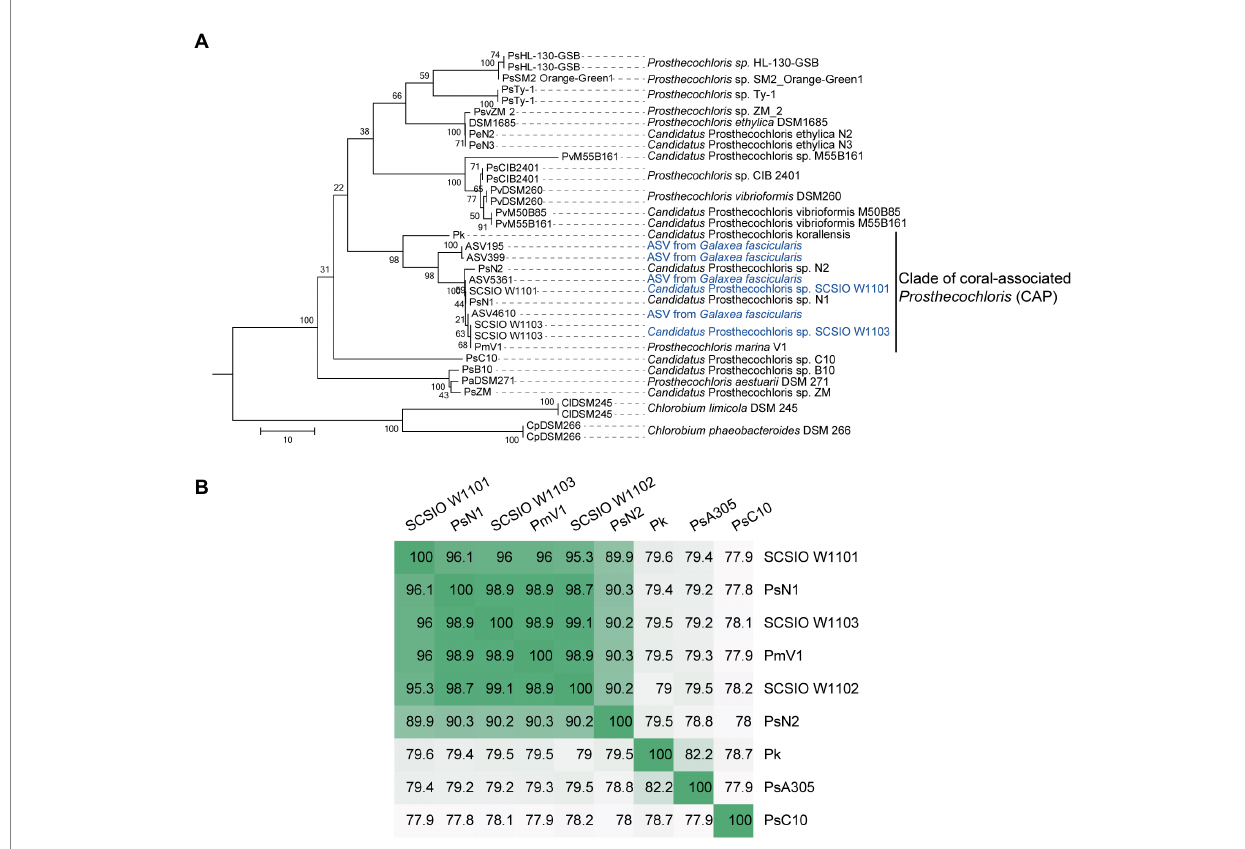
FIGURE 2 Classification of coral-associated Prosthecochloris (CAP) genomes. (A) The neighbor-joining tree was constructed using MEGA software with 1,000 bootstraps after aligned by MAFFT. Sequences of 16S rRNA genes of other Prosthecochloris genome assemblies listed in Table 1 were extracted. Sequences of amplicon sequence variants (ASVs) were extracted from our previous full-length 16S rRNA gene amplicon sequencing data of Galaxea fascicularis samples (Wang et al., 2022). Sequences from two Chlorobium strains were used as the outgroup. Branch lengths are proportional to the number of nucleotide substitutions. A short name for each genome assembly is shown at the end of each branch. (B) Average nucleotide identity of CAP genomes. Candidatus Prosthecochloris sp. C10 (abbreviated as PsC10) is the closest non-CAP clade Prosthecochloris